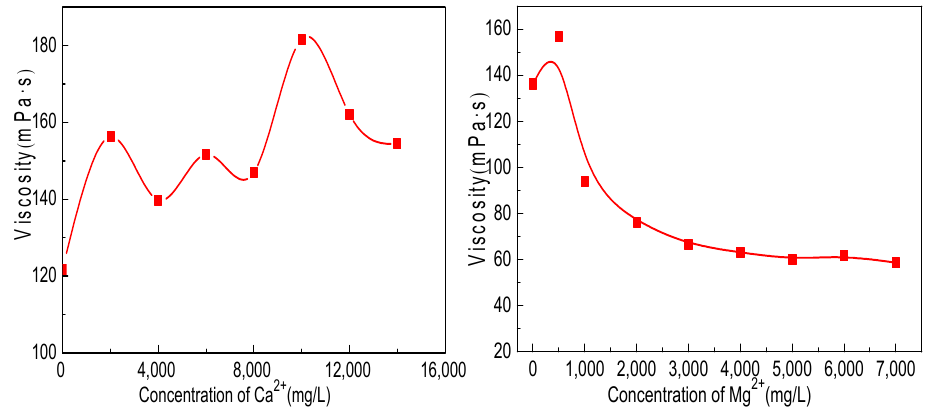
Figure 12. Effect of Ca 2+ /Mg 2+ concentration on apparent viscosity of a DiPHAM aqueous solution. Figure 13 shows that there is a solubility product balance among –COO − groups and Ca 2+ /Mg 2+ ions that can lead to precipitation when the ion product is higher than the solubility product, and